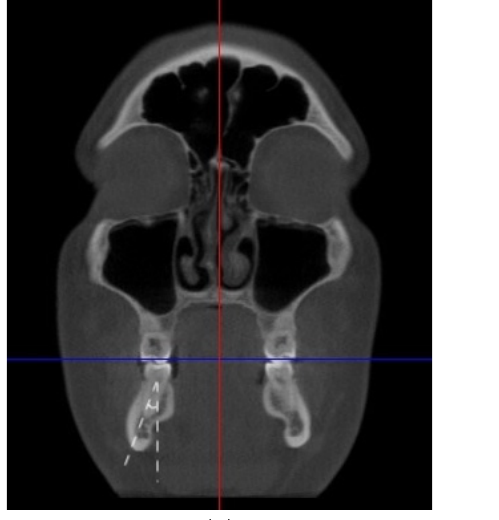
Table 1. The measurements of inclinations of lower first molars and their alveolar bones, and vertical cephalometric